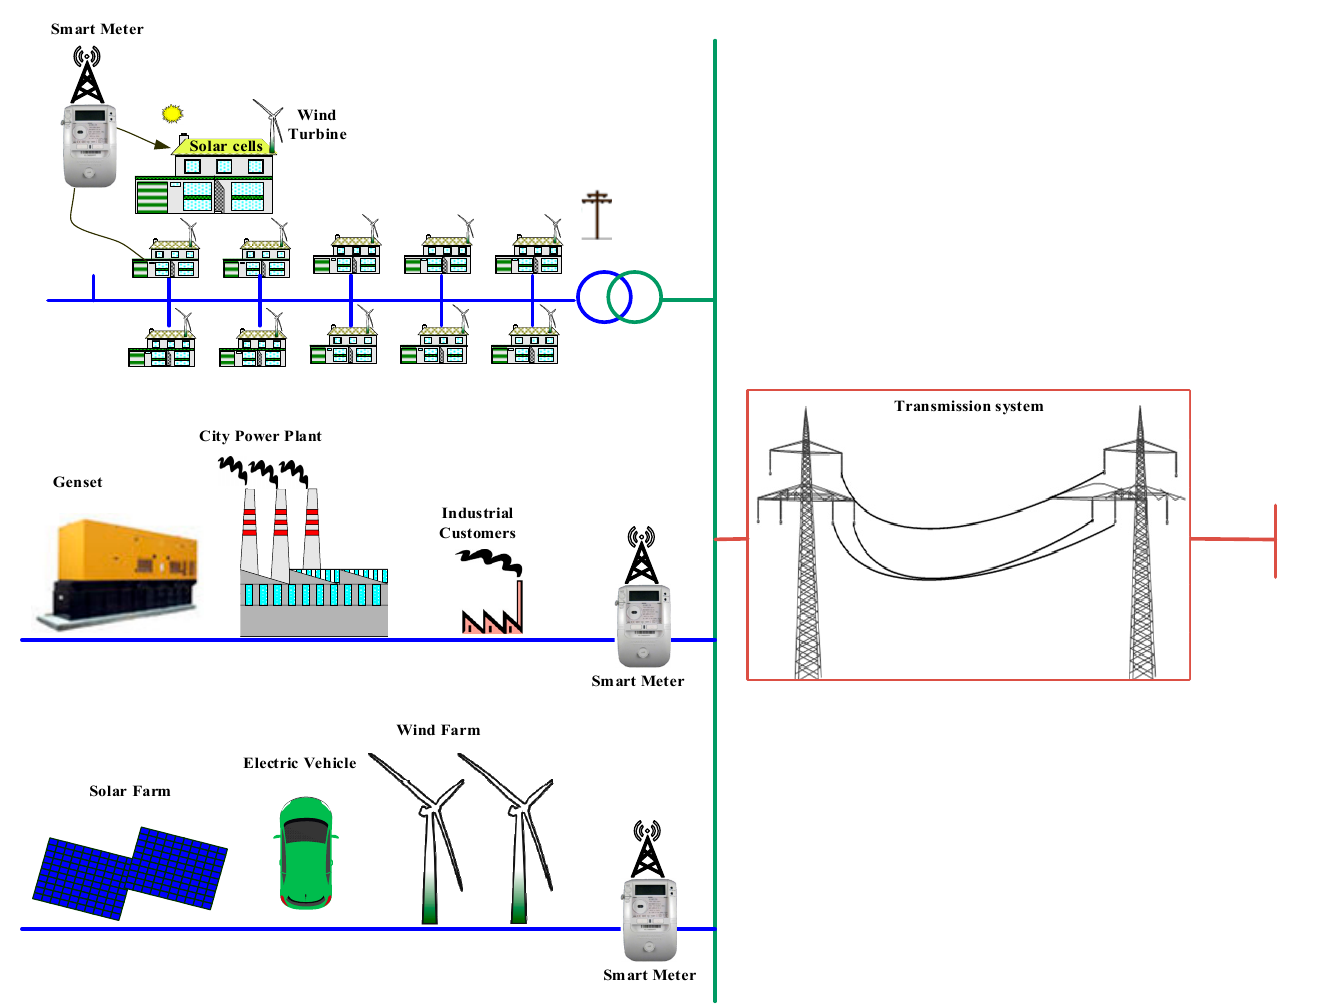
Figure 2. Smart grid with distributed power suppliers.